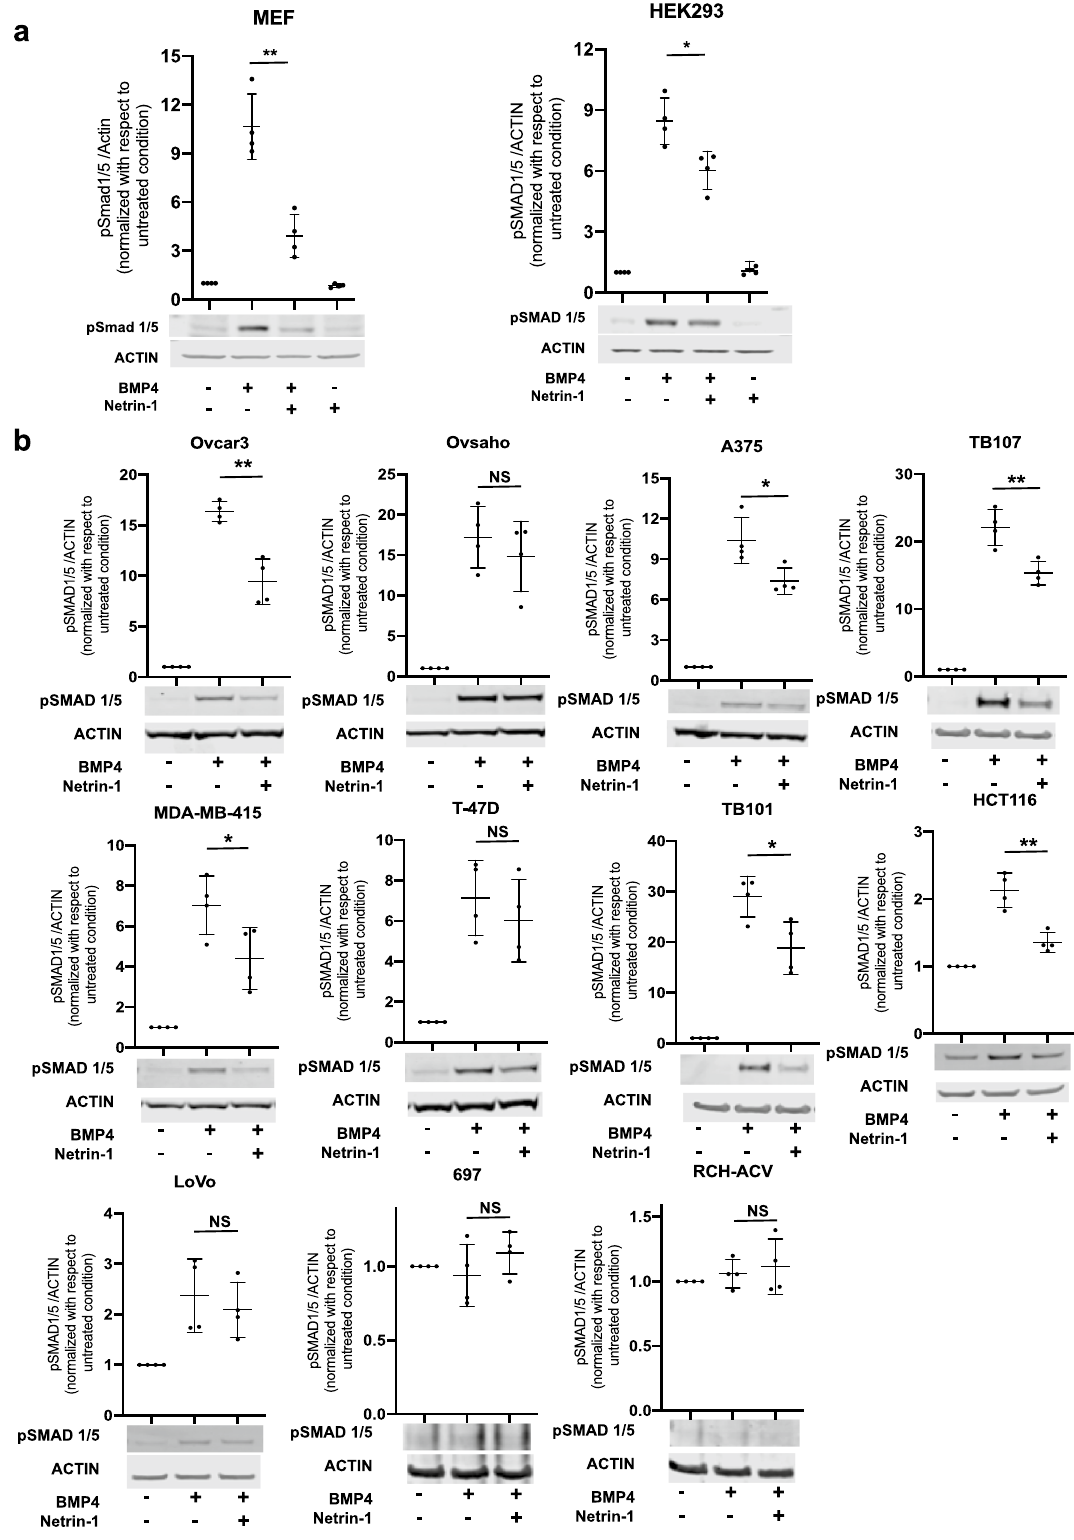
Figure 2. Netrin-1 inhibits BMP signaling in various mammalian cell lines. Western blot analysis showing the inhibitory effect of netrin-1 on the BMP4-induced pSmad1/5 levels in cell lines of different origins. ( a ) MEFs and human embryonic kidney (HEK293) cells. ( b ) Human ovarian cancer (Ovcar3 and Ovsaho), malignant melanoma (A375), breast cancer (MDA-MB-415 and T-47D), glioblastoma (TB101 and TB107), colorectal carcinoma (HCT116 and LoVo), and acute lymphoblastic pre-B cell leukemia (697 and RCH-ACV). Representative Western blots of pSMAD1/5 and actin after the cells were treated with BMP4 and netrin-1 are shown together with the quantifications of the pSMAD1/5/actin ratios. Uncropped blots are shown in Fig. S4. Shown are the means and individual values of four independent experiments (Student’s t -test: NS p ≥ 0.05; *p < 0.05; **p <